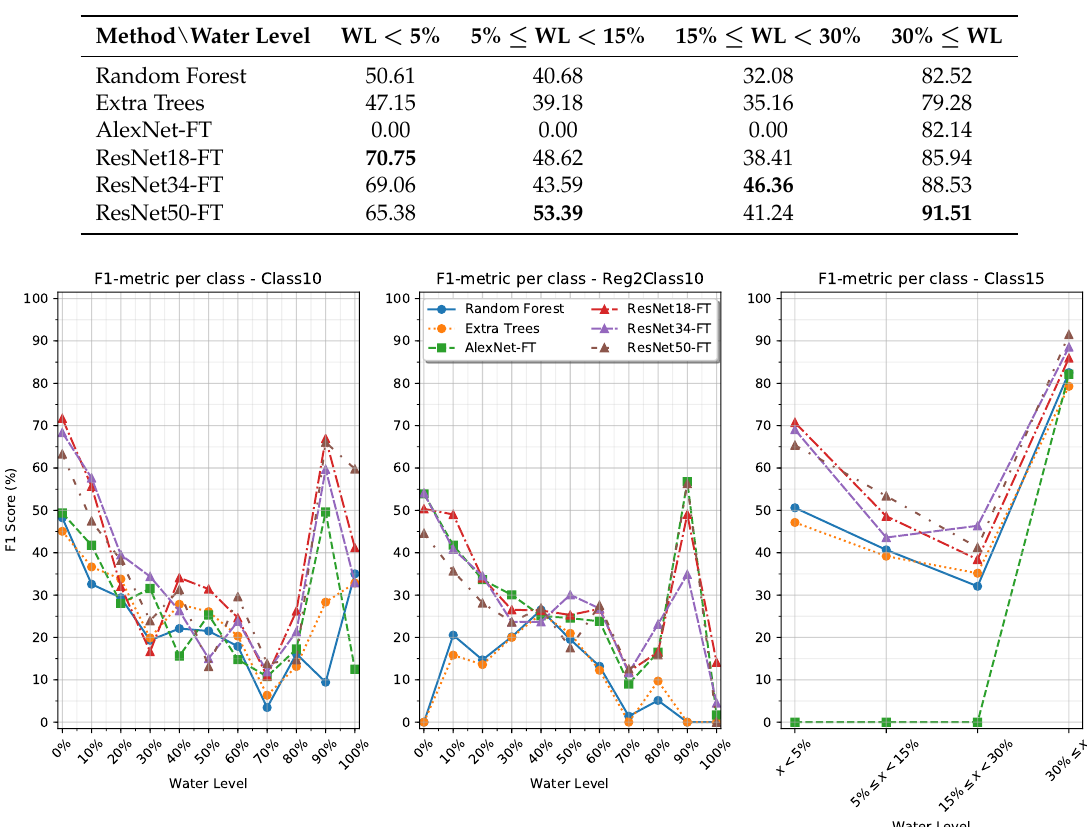
Table 9. Per-class F1 score for each method—Class15 training setting.